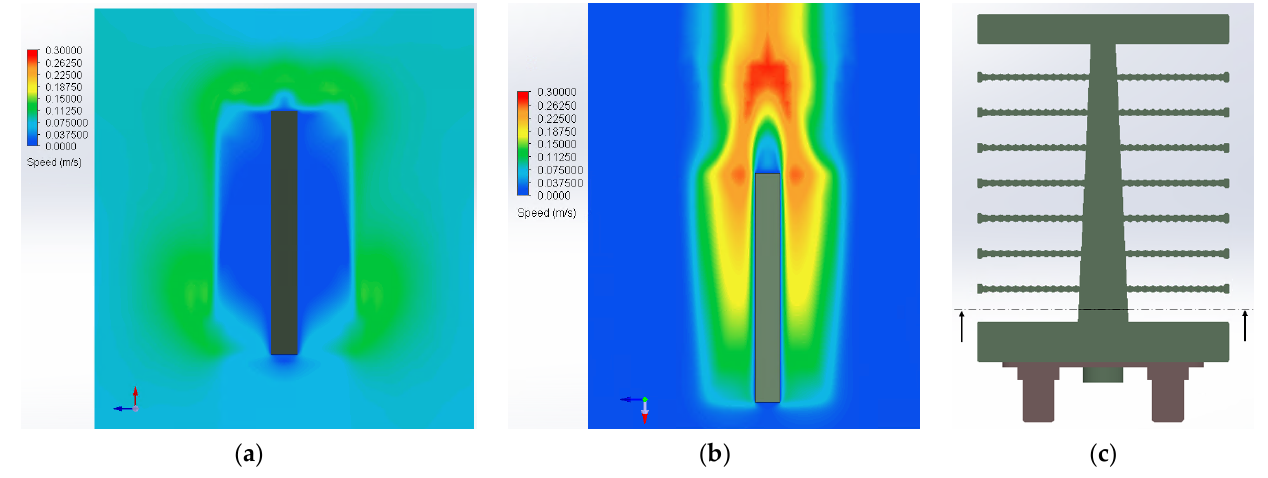
Figure 16. ( a ) Air velocity of Setup 1—section view; ( b ) Air velocity of Setup 2—section view; ( c ) Section plane.